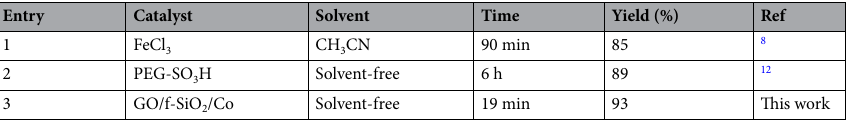
Table 3. comparison the various catalysts for the synthesis of spiro